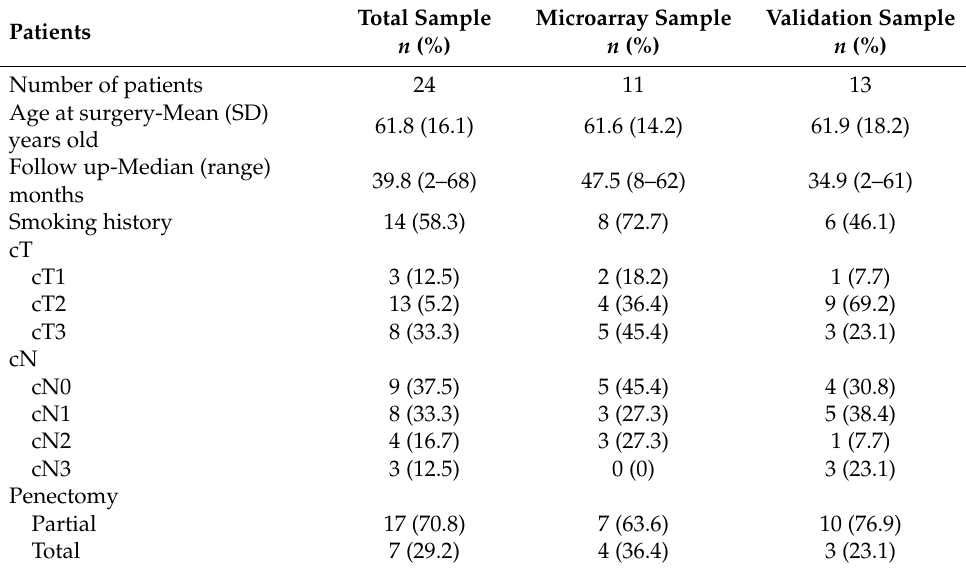
Table 1. Clinical and histopathological characteristics of PeC patients for each set of